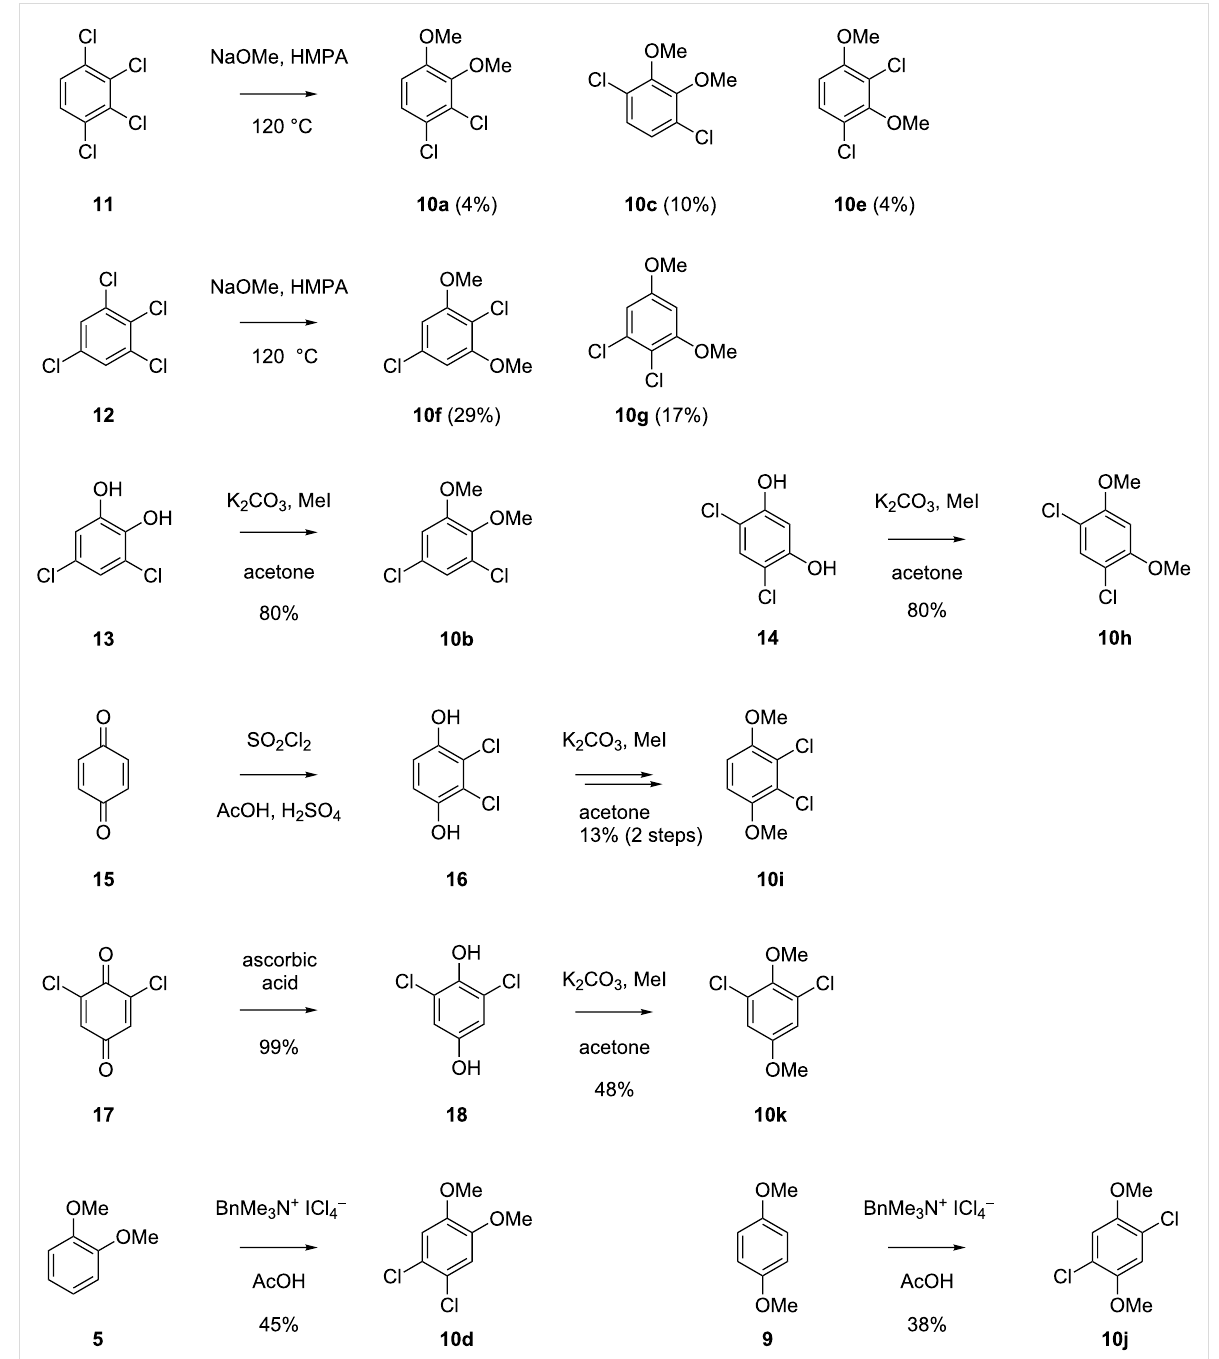
Scheme 2: Synthesis of chlorodimethoxybenzenes as reference compounds for Y .